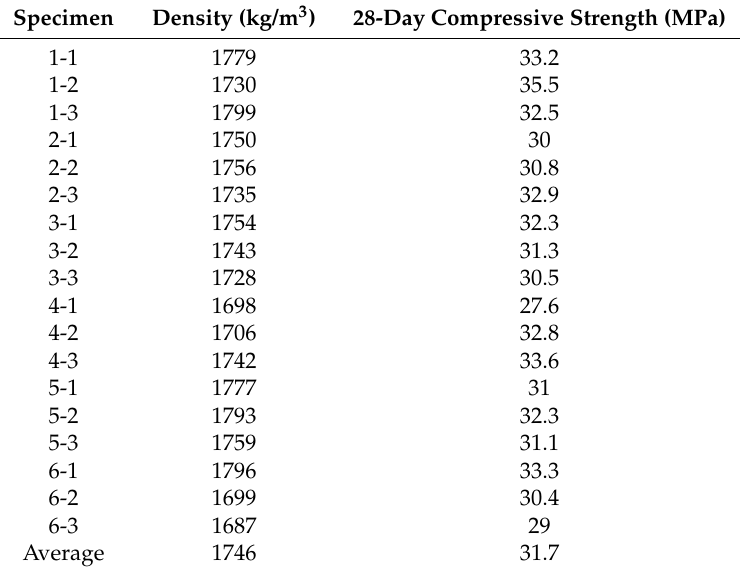
Figure 2. YAS ‐ 5000 compression ‐ testing machine.